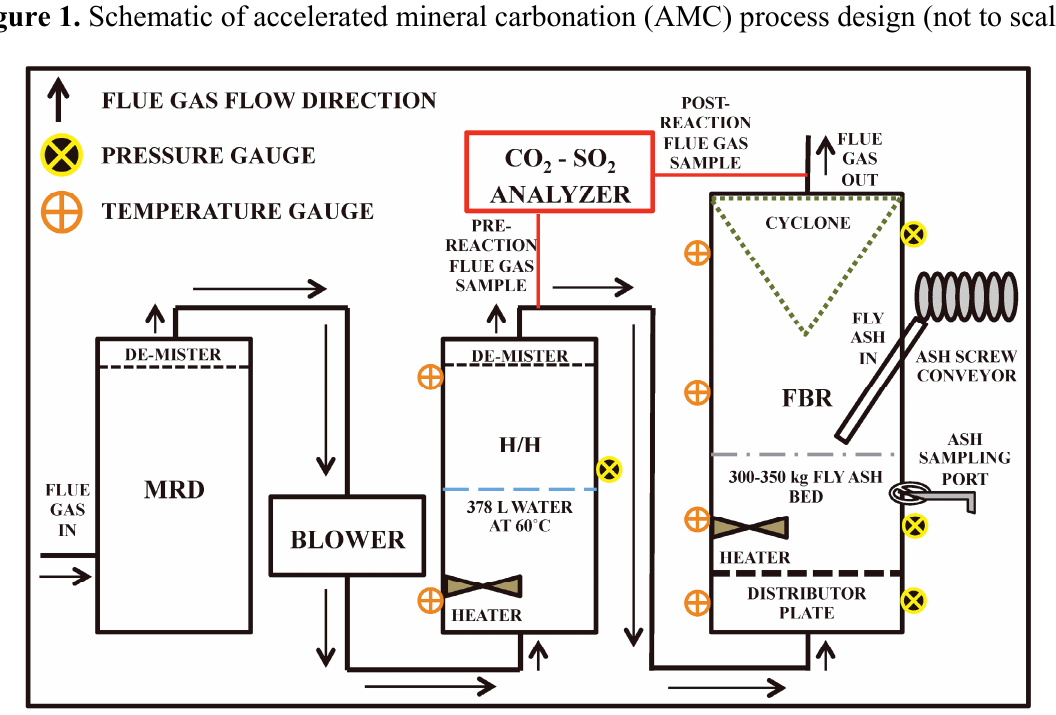
Figure 1. Schematic of accelerated mineral carbonation (AMC) process design (not to